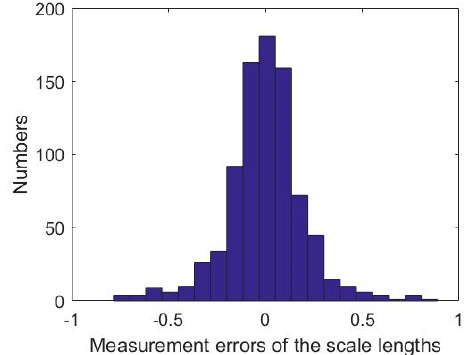
Figure 6. Histogram of the length reconstructing errors.